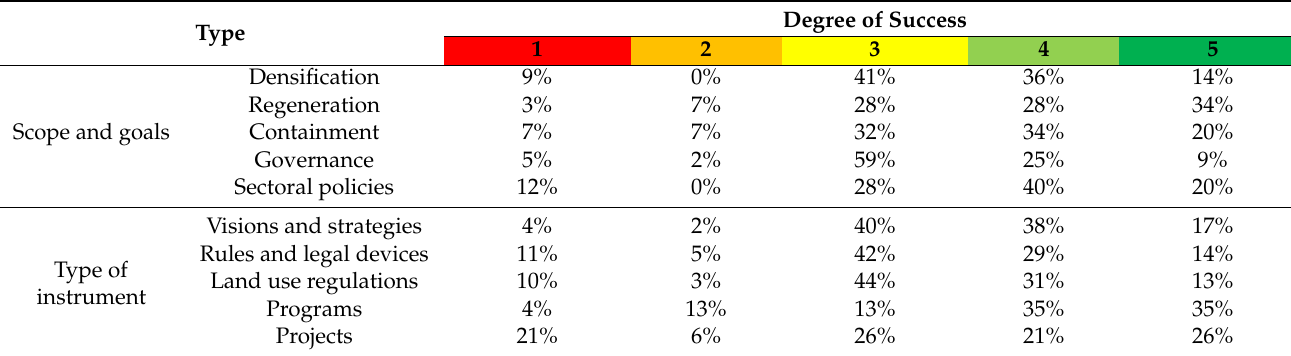
Table 3. Degree of success of the analyzed interventions in relation to their scope and goals and to the type of instrument they adopted (source: authors’ own